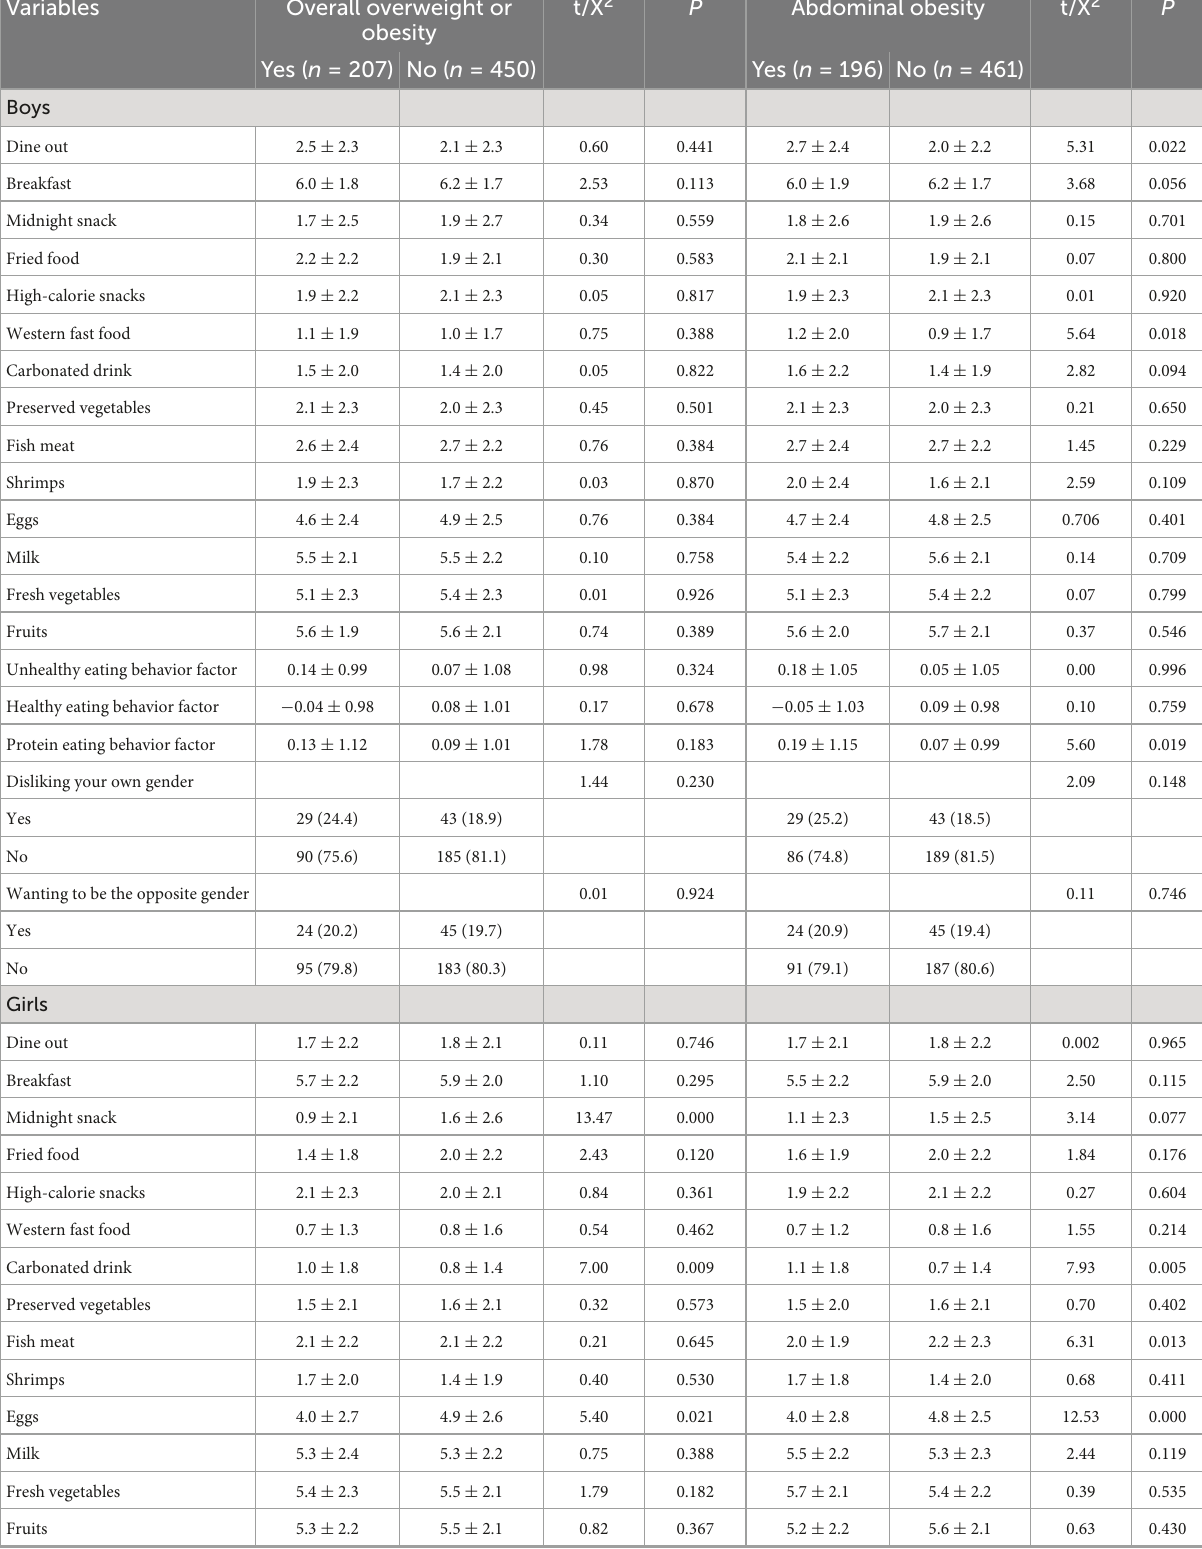
TABLE 3 Comparisons of differences in eating behaviors, negative gender attitude between children and adolescents with different body shapes. Variables Overall overweight or t/X 2 P Abdominal obesity t/X 2 obesity